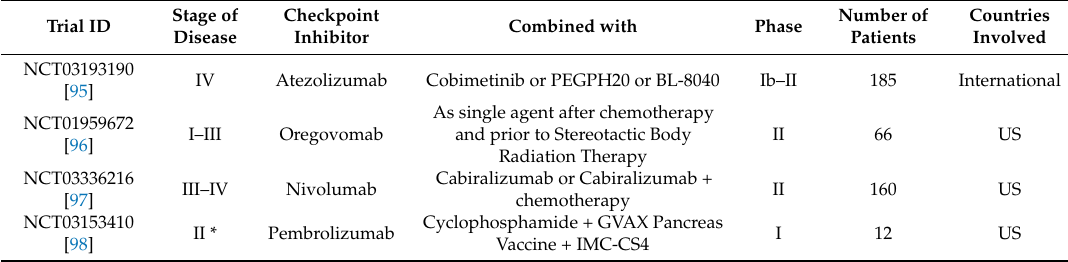
Table 1. Clinical trials registered on Clinicaltrials.gov that are utilising checkpoint inhibitor-based immunotherapy, and are currently recruiting or due to recruit patients with pancreatic ductal